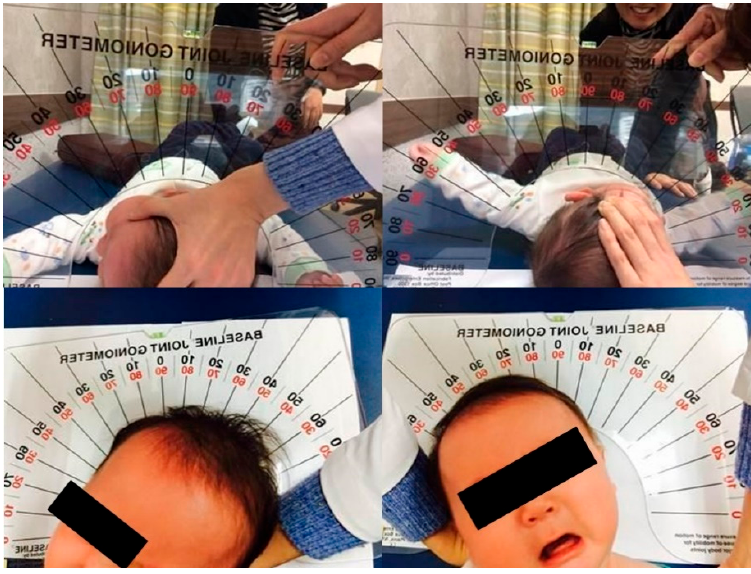
Figure 4. Cervical range of motion measurement using arthrodial goniometer.